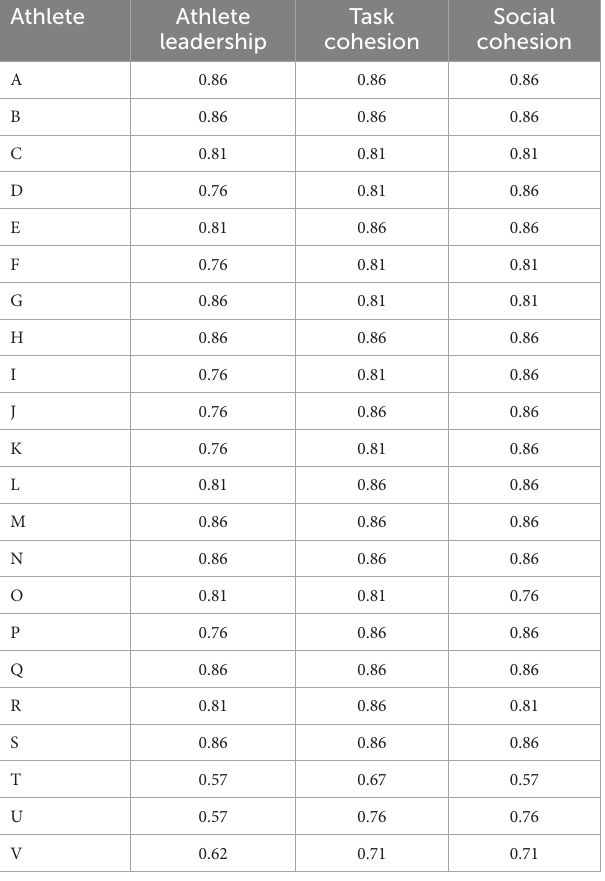
TABLE 1 Normalized indegree centrality for Athlete Leadership and Cohesion networks.